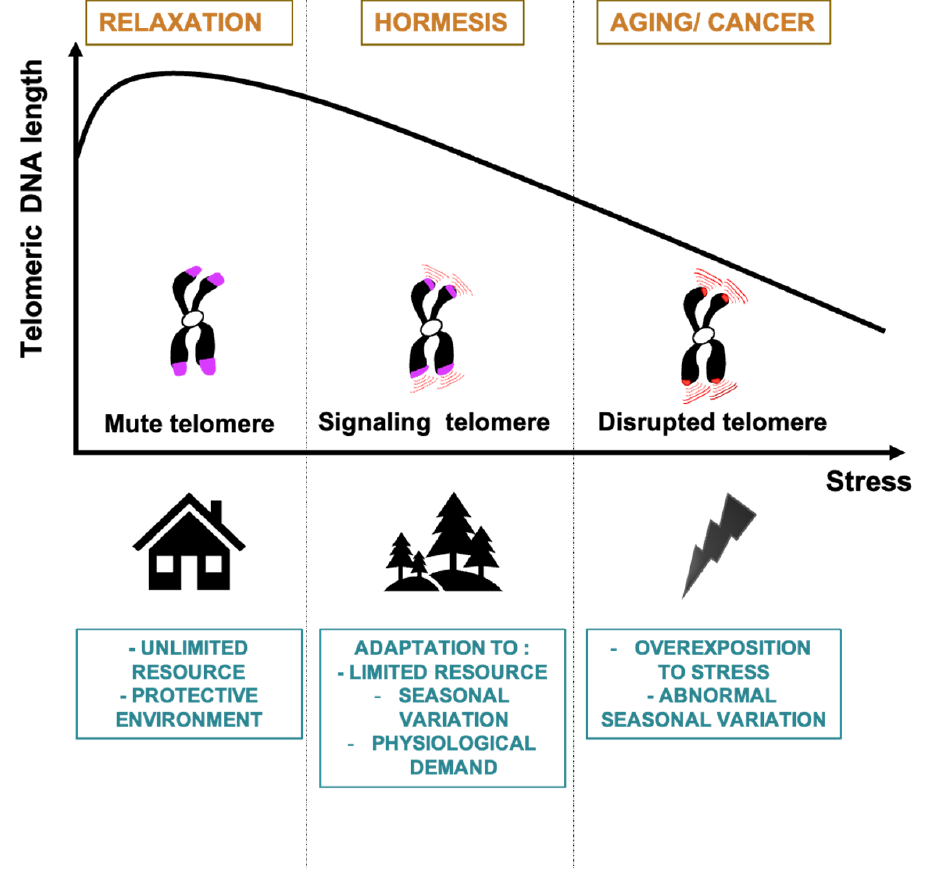
Figure 3. The telo-hormesis hypothesis. Under exposure to predicted stresses (such as regular sea- sonal fluctuations and limited resource) or normal/physiological demands, telomere integrity might be affected in order to trigger a hormetic signal through transcriptional changes and mito-hormesis. To stop an early oncogenic event, this hormetic signaling can also result in cellular senescence. Un- der unexpected, overexposure and acute stresses, telomere integrity can be dramatically disrupted leading to detrimental effects with an excessive chromosome instability resulting in premature aging and cancer development. In contrast, in protective, unchallenged conditions, one can speculate that telomeres are in a “mute” state that just protect chromosome ends but without leading to any benefi- cial or detrimental signaling, resulting in the “relaxation” of the TL regulation processes, possibly leading to heterogenous and long telomeres, such as those present in laboratory mice.